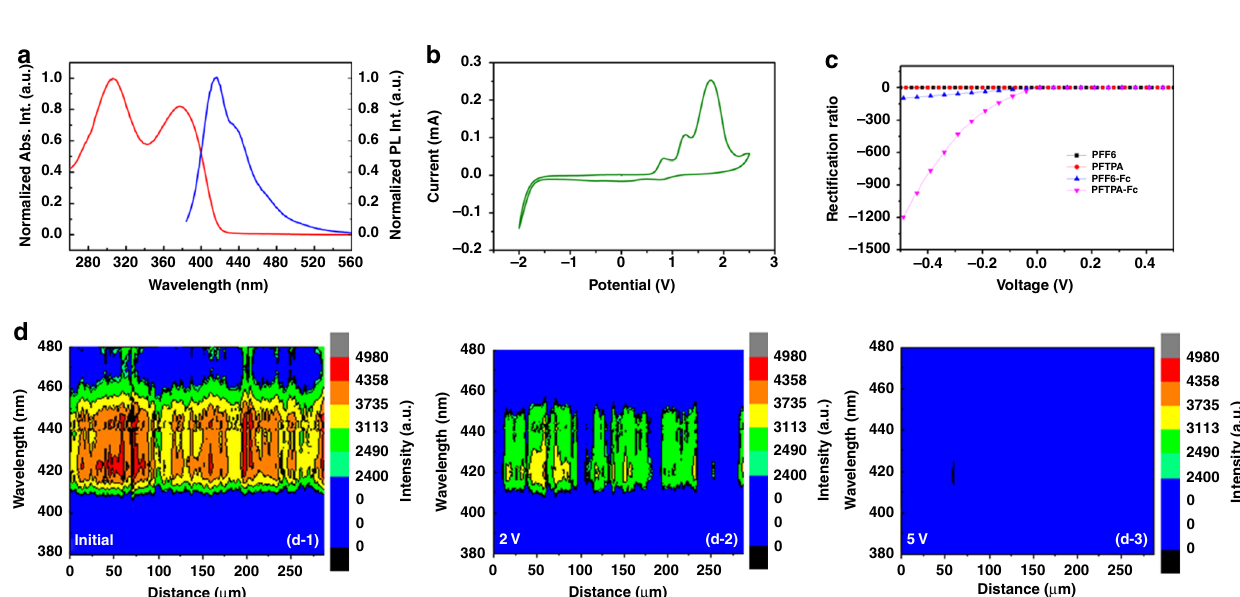
Fig. 1 Synthesis of the redox active polymer